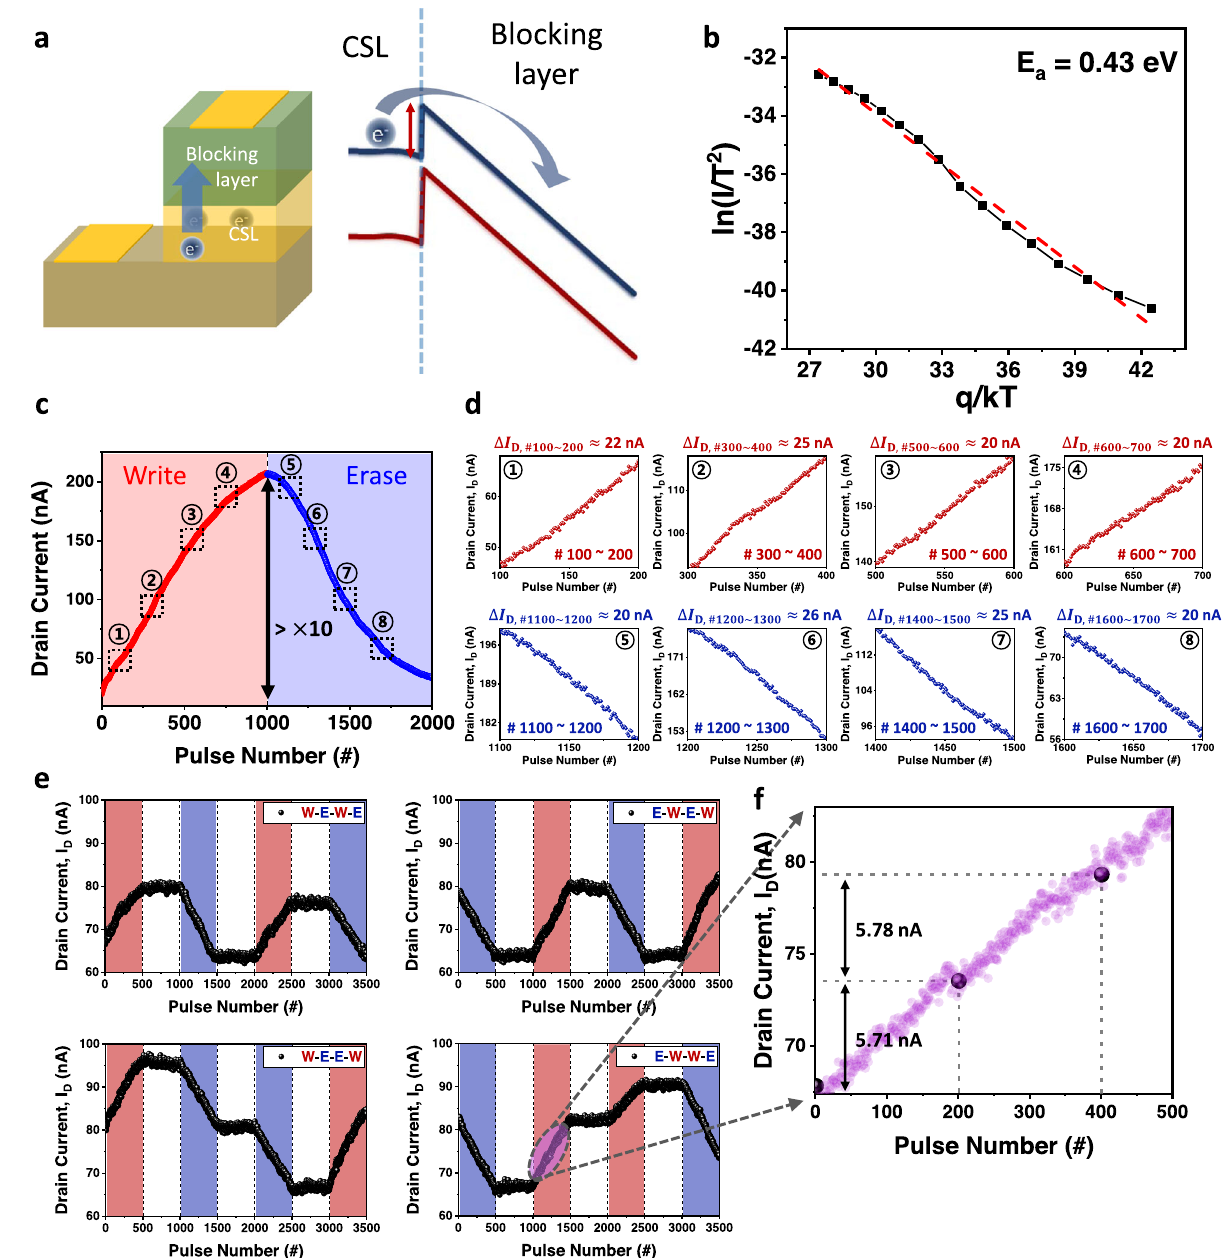
Fig. 2 | The linearity of GIFET and its relationship with the conduction mechanism. a Schematic of the GIFET gate stack without gate oxide and band diagram of CSL and blocking layer during write operation. The barrier exists betweentheCSLandtheblockinglayer,andthechargeintheCSLisextractedover thebarrier. b TheArrheniusplotmeasuredfromWO x /a-Si:HstackwithouttheSiO 2 layer between the channel and the stack from 273K to 423K. c The LTP-LTD characteristic of GIFET under 1000 write (5V, 500 μ s) − 1000 erase ( − 3.3V, 500 μ s) consecutive pulse scheme (1V, 50 μ s read voltage and 50 μ s between each pulse